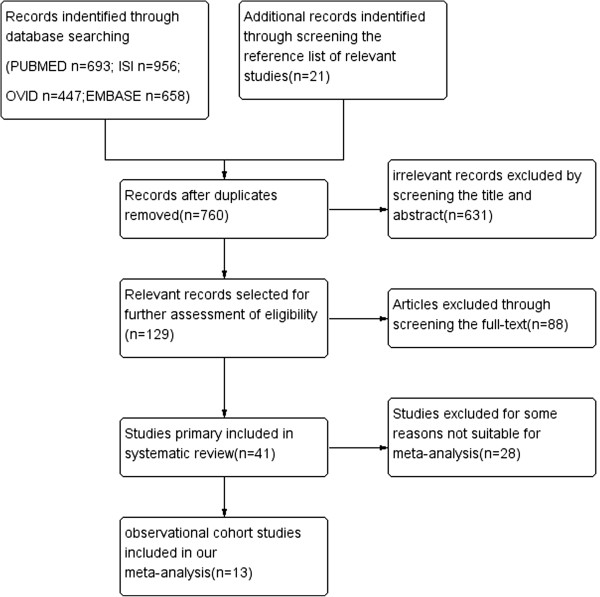
Study flow diagram of study selection.